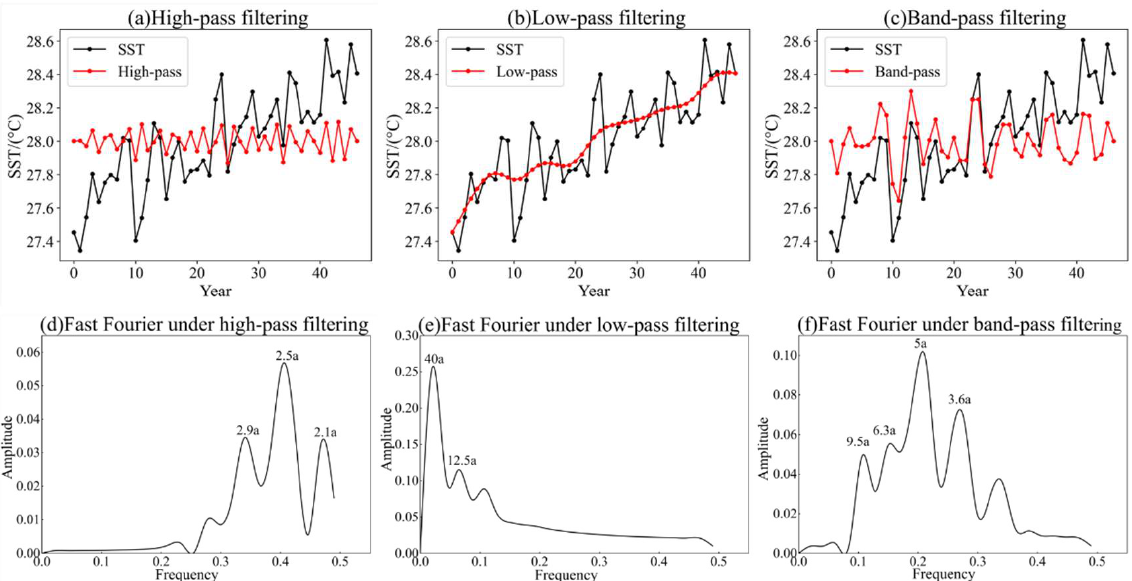
Figure 4. Fast Fourier transform of SST time series after filtering, a represents the year. ( a , d ) high-pass; ( b , e ) low-pass; ( c , f ) band-pass.